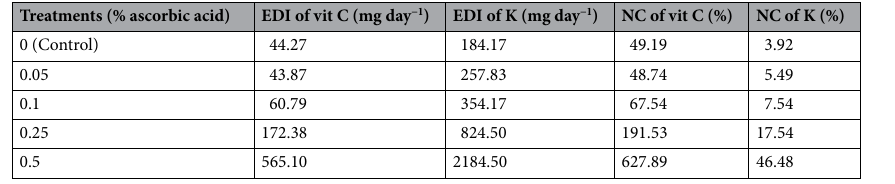
Table 4. Average of estimated daily intake and nutrient contribution of Vit C and K for all the treatments. Because these calculations are functions of presented data, no statistical analysis was conducted. EDI estimated daily intake, NC nutrient